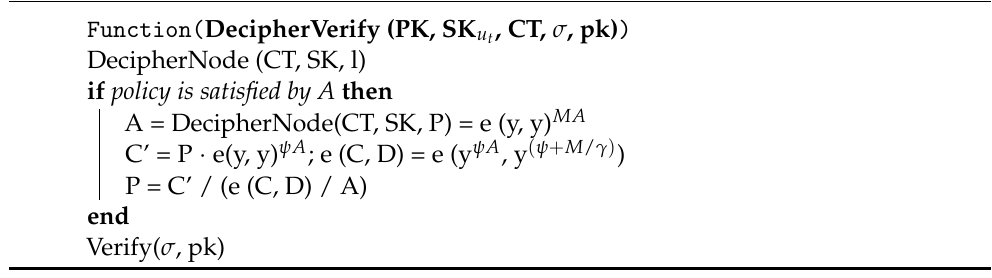
Algorithm 4: Algorithm for Decryption and Verification